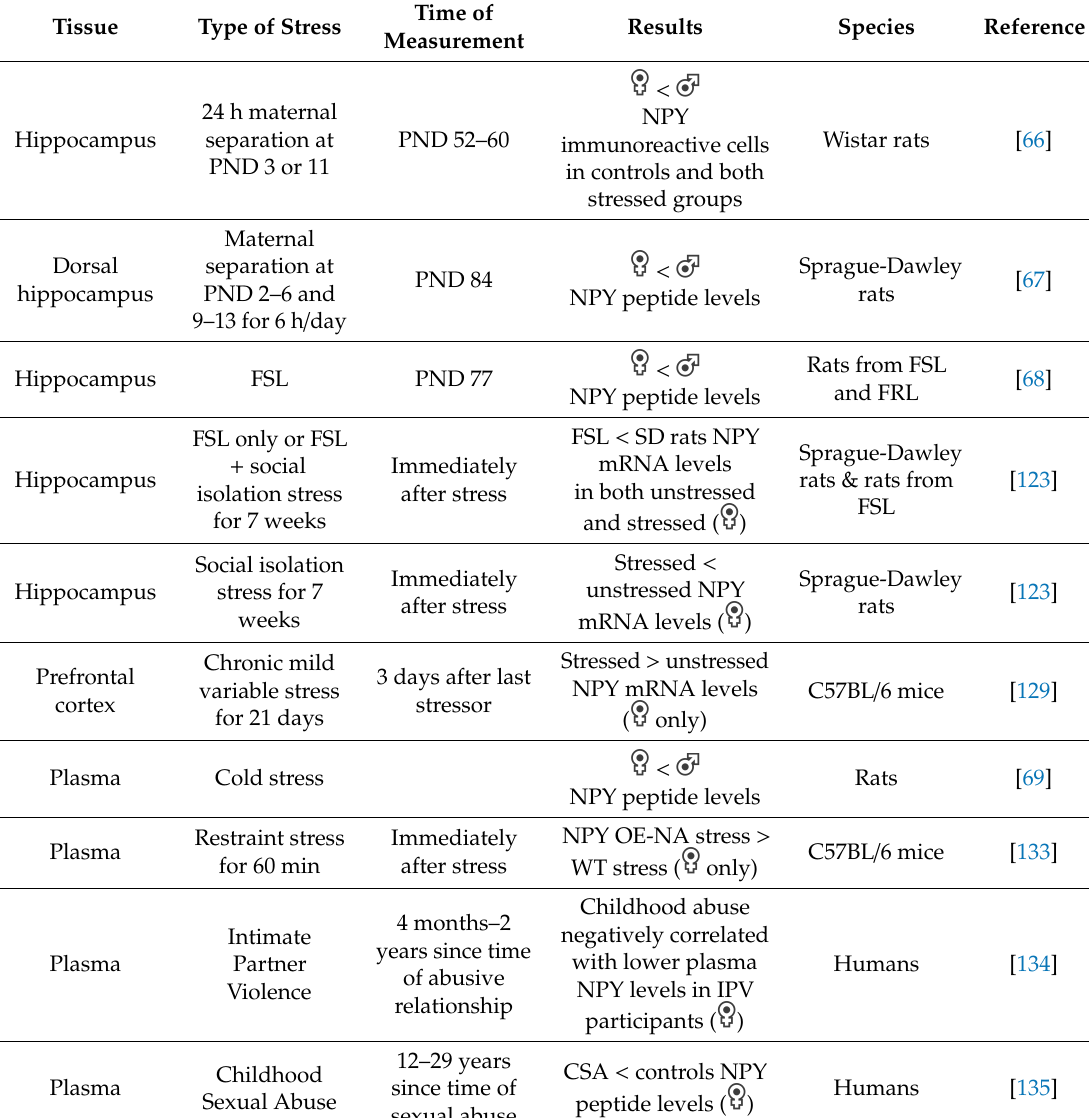
Table 1. Sex differences in NPY expression levels in unstressed conditions.